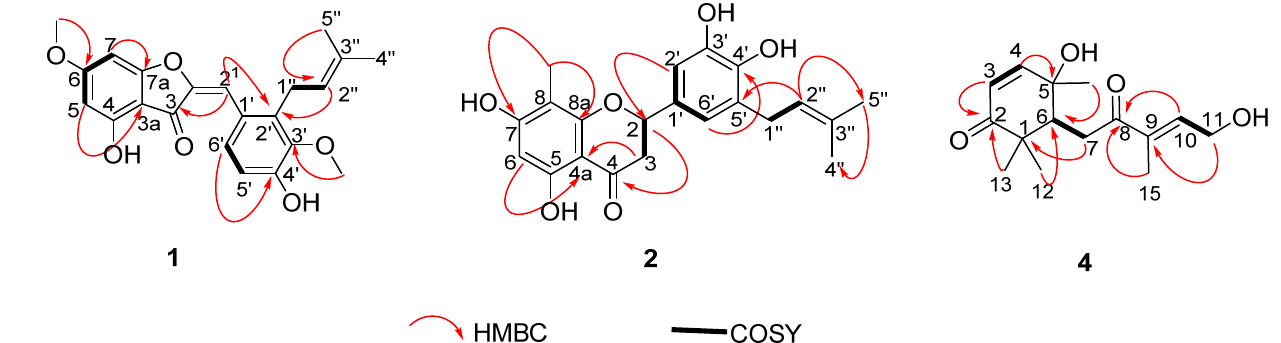
Figure 2. Diagnostic HMBC and COSY correlations of 1 , 2 , and 4.